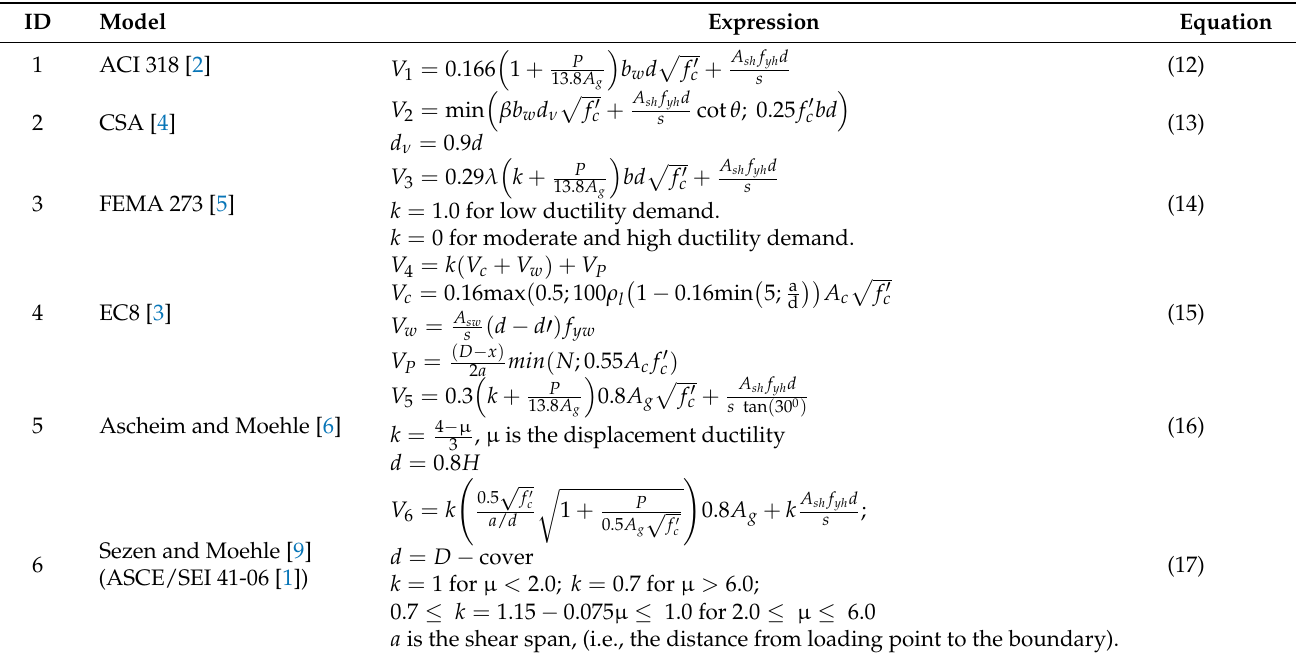
Table 2. Formulas for calculating shear strength of rectangular RC